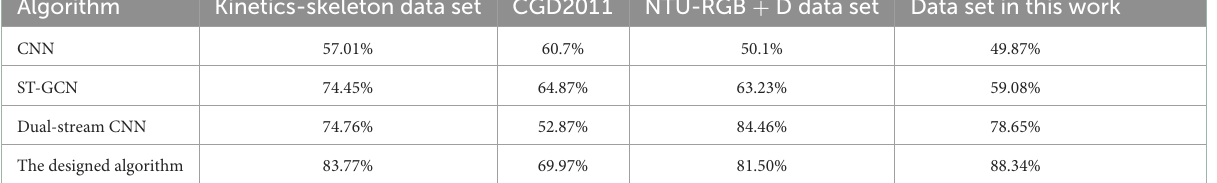
TABLE 2 Performance